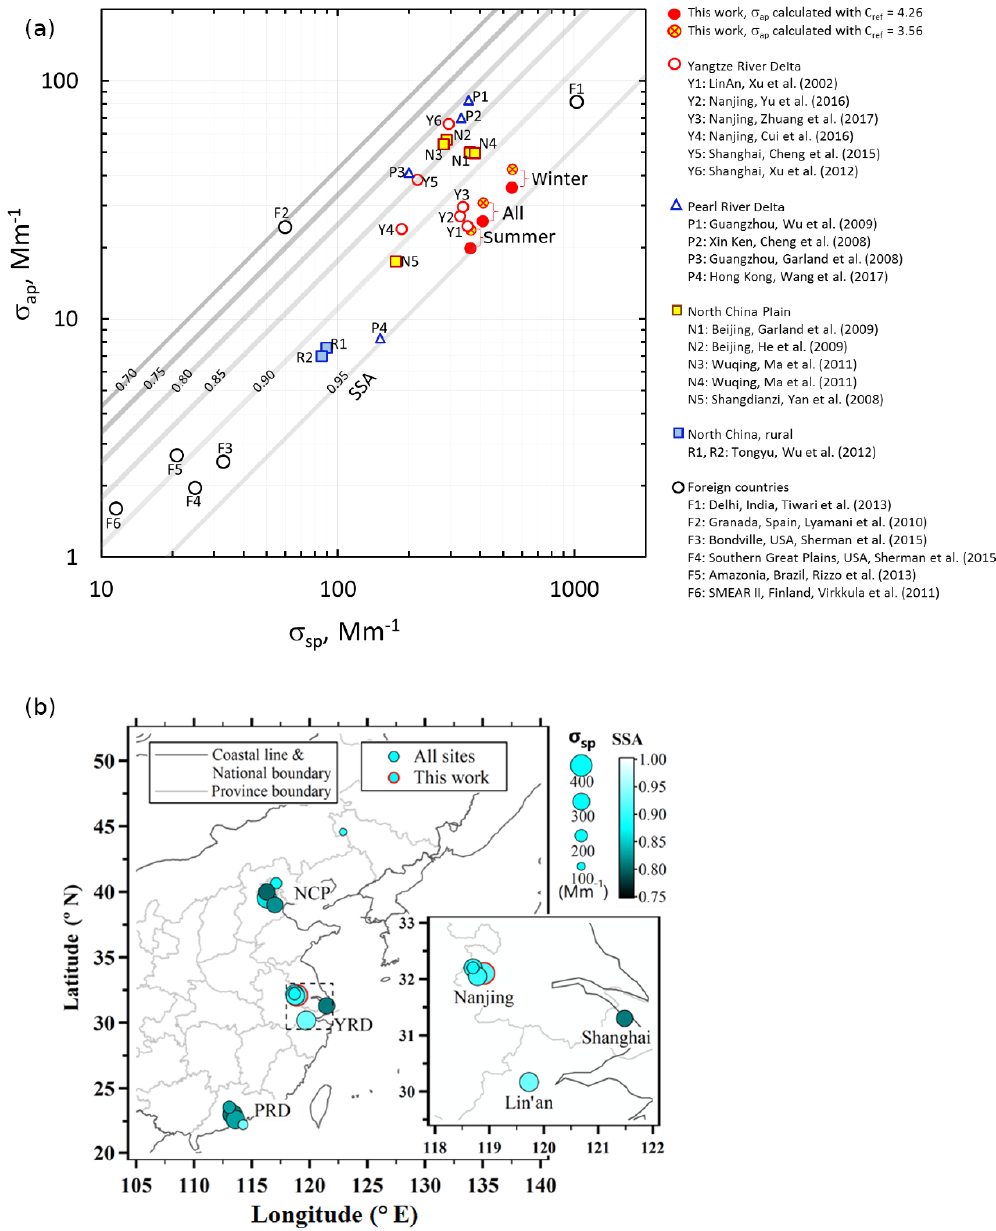
Figure 2. (a) Average absorption coefficient ( σ ap ) vs. average scattering coefficient ( σ sp ) of green light at SORPES (this work) and selected Chinese and foreign sites. For SORPES, the averages for the whole period (Table 1) and for summer and winter (Table 3) are presented with two symbols: the solid red circles and the circles with the red cross for which σ ap was calculated by using C ref = 4 . 26 and 3.56, respectively. For details of measurement methods, periods, wavelengths, and references of the comparison sites see Table 2. Constant single-scattering albedo (SSA) is depicted by the solid grey lines. (b) the locations of some of the studies mentioned in Table 2, the size and color of each cycle represent the scattering coefficient and single-scattering albedo, respectively, the circle with a red margin is the SORPES site.